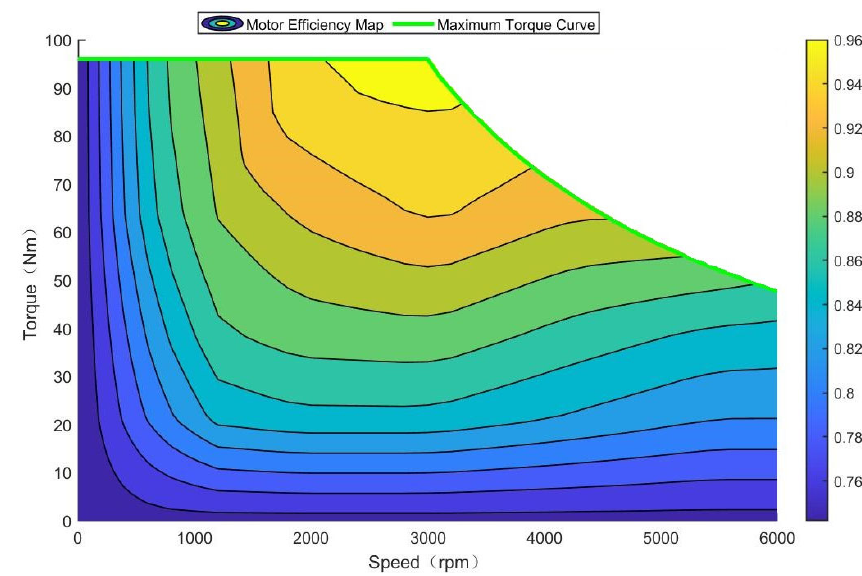
Figure 2. Motor model MAP diagram.